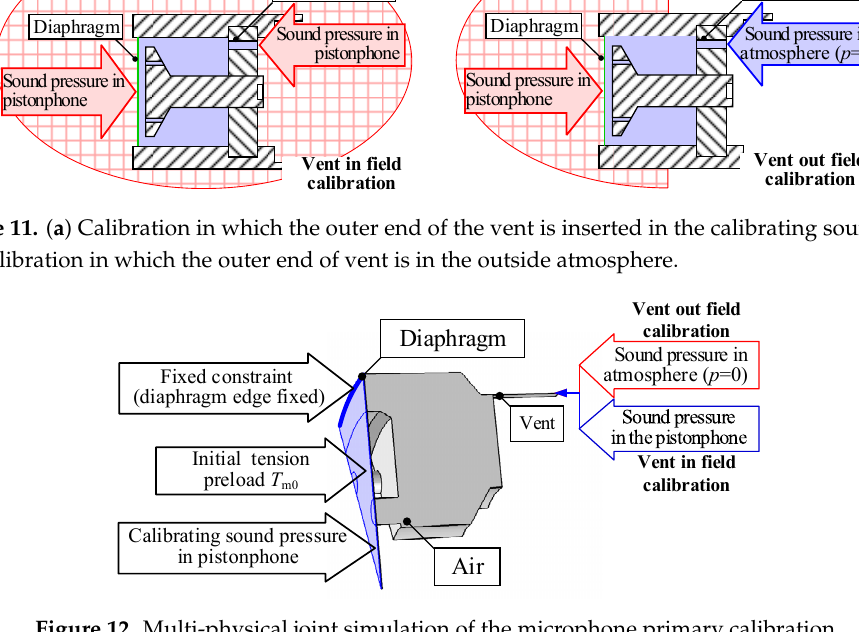
Figure 12. Multi-physical joint simulation of the microphone primary calibration.